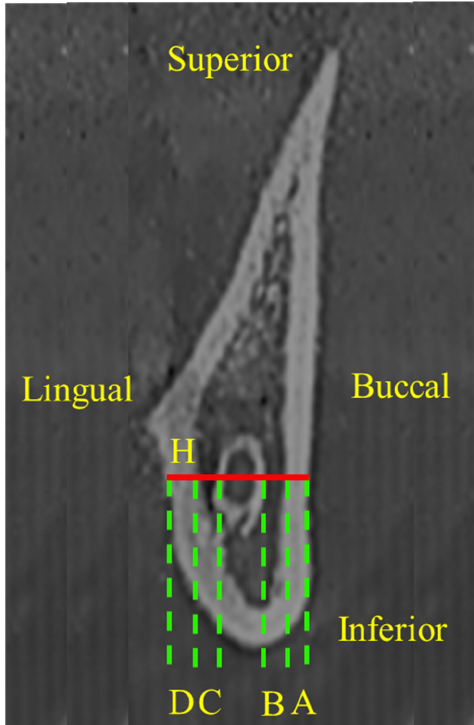
Figure 2. Red line distance (H: thickness of mandible). A: buccal cortical bone thickness; B: buccal cortical bone marrow thickness; C: lingual bone marrow thickness; D: lingual cortical bone thick- ness.